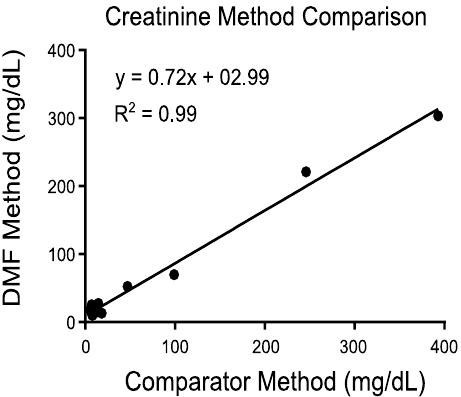
Figure 5. Analysis of urine samples using DMF. Method comparison using the DMF method (y-axis) for creatinine versus the comparator method using mass spectrometry (x-axis).